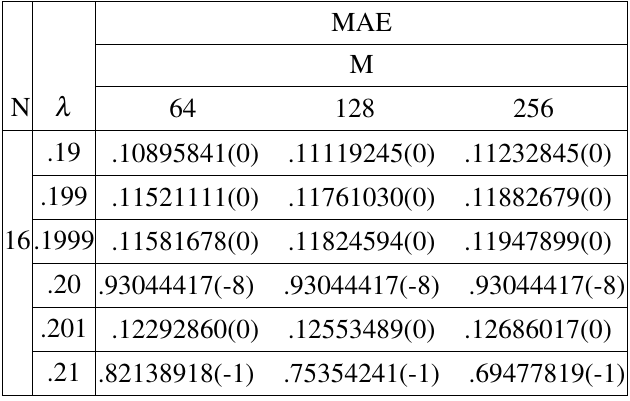
Table 4 Maximum absolute error (Problem